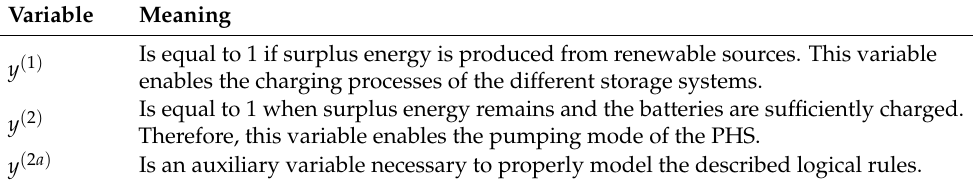
Table 1. Summary of binary variables for mixed-integer-logical programming model for optimal coordination of BES and